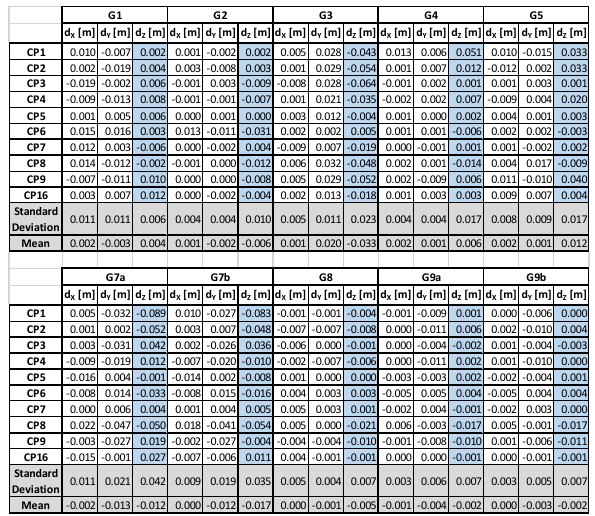
Table 1 . Differences on the CPs estimated coordinates.